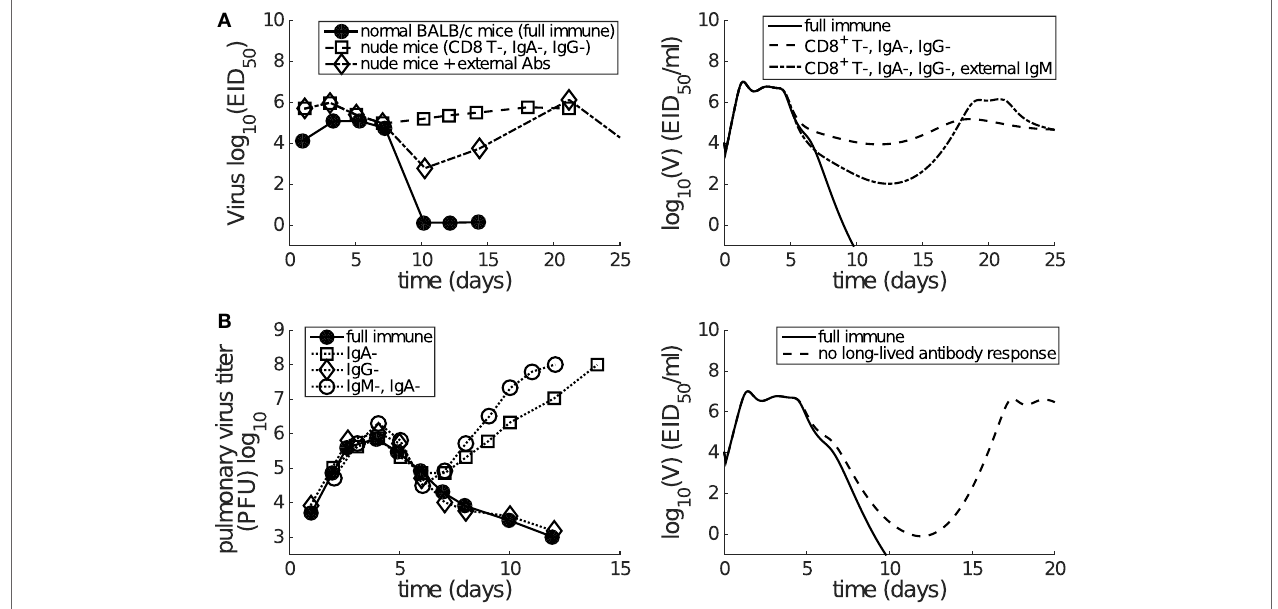
FIGURE 5 | Consistency between mice data (left panels) and model results (right panels) shows that short-lived antibody response (e.g., IgM) is only capable of generating a transient decrease in viral load while long-lived antibody response (e.g., IgA) plays a more dominant role in late-phase viral clearance . (A) Data are from the paper of Kris et al. (44). Normal or nude BALB/c mice were infected with H3N2 virus. External antibodies were given at day 5 and had waned by about day 21. The model simulation mimics the passive antibody input by introducing an extra amount of IgM (in addition to antigen-stimulated IgM), whose time course faithfully follows the experimental measurement (see Figure 2A in the paper of Kris et al. (44)). “CD8 + T-, IgA-, IgG-” was modeled by letting β Cn = 0 and p L = 0. “External IgM” (in addition to the IgM produced by plasma cells) was modeled by adding a new term (cid:0) κ S VA e ( t ) to equation (1), where A e ( t ) follows a piecewise function A e ( t ) = 0 for t < 5, A e ( t ) = 100( t (cid:0) 5) for t 2 [5, 7], A e ( t ) = 200 (cid:0) 14( t (cid:0) 7) for t 2 [7, 21], and A e ( t ) = 0 for t (cid:21) 21. (B) Data are from the paper of Iwasaki and Nozima (12). The data indicate that the long-lasting IgA response, but not the long-lasting IgG response or the short-lasting IgM response, is necessary for successful viral clearance. “No long-lived antibody response” was modeled by letting p L = 0. Note that Miao et al. only measured IgM and IgG, but